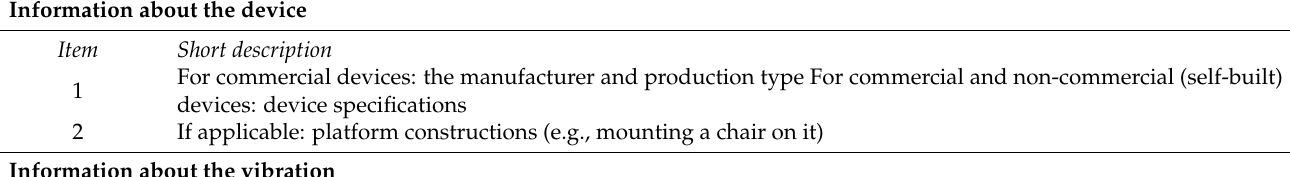
Table 1. Checklist of information to include in WBV studies in humans.